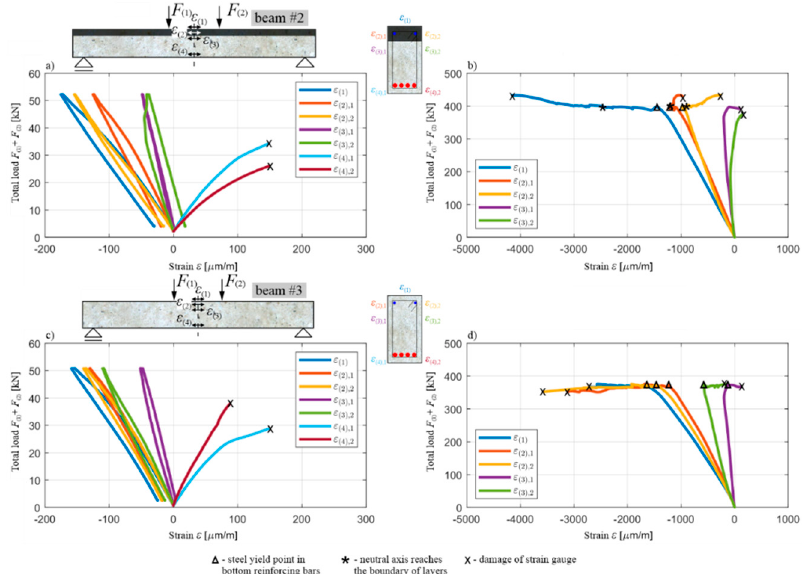
Figure 29. Diagram of the total load in the function of the measured strains at the middle of the span for beam #2 in stage 1 ( a ) and stage 4 ( b ), and beam #3 in stage 1 ( c ) and stage 4 ( d ).